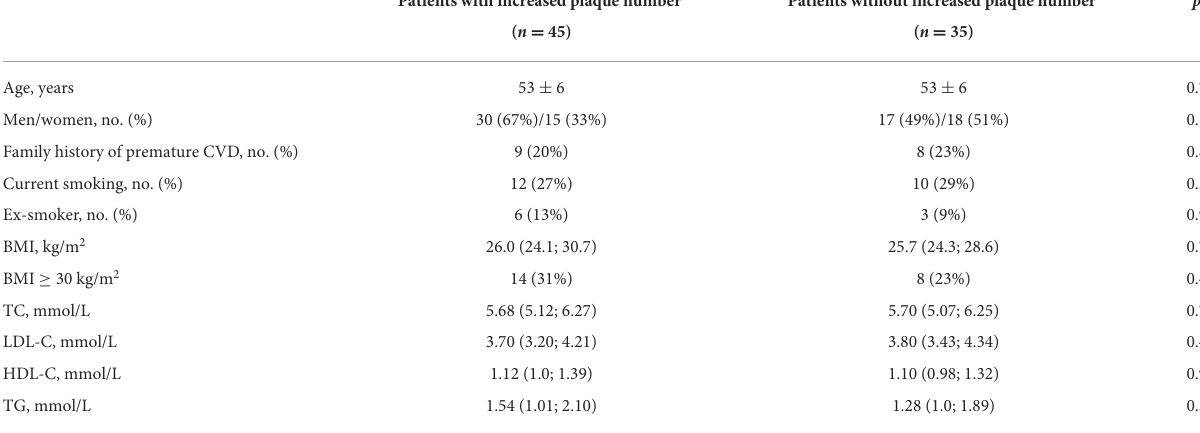
Patientswith increased plaque